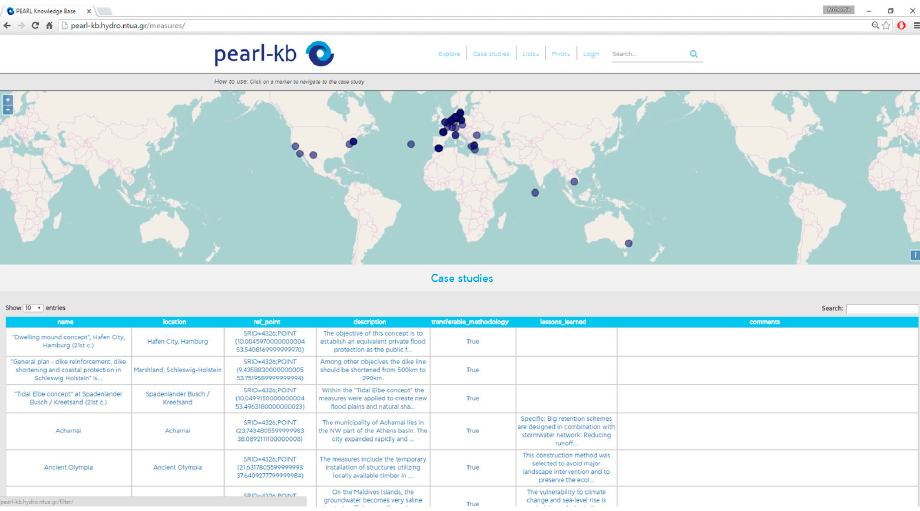
Figure 5. Exploring applications of measure(s) implemented all over the world.